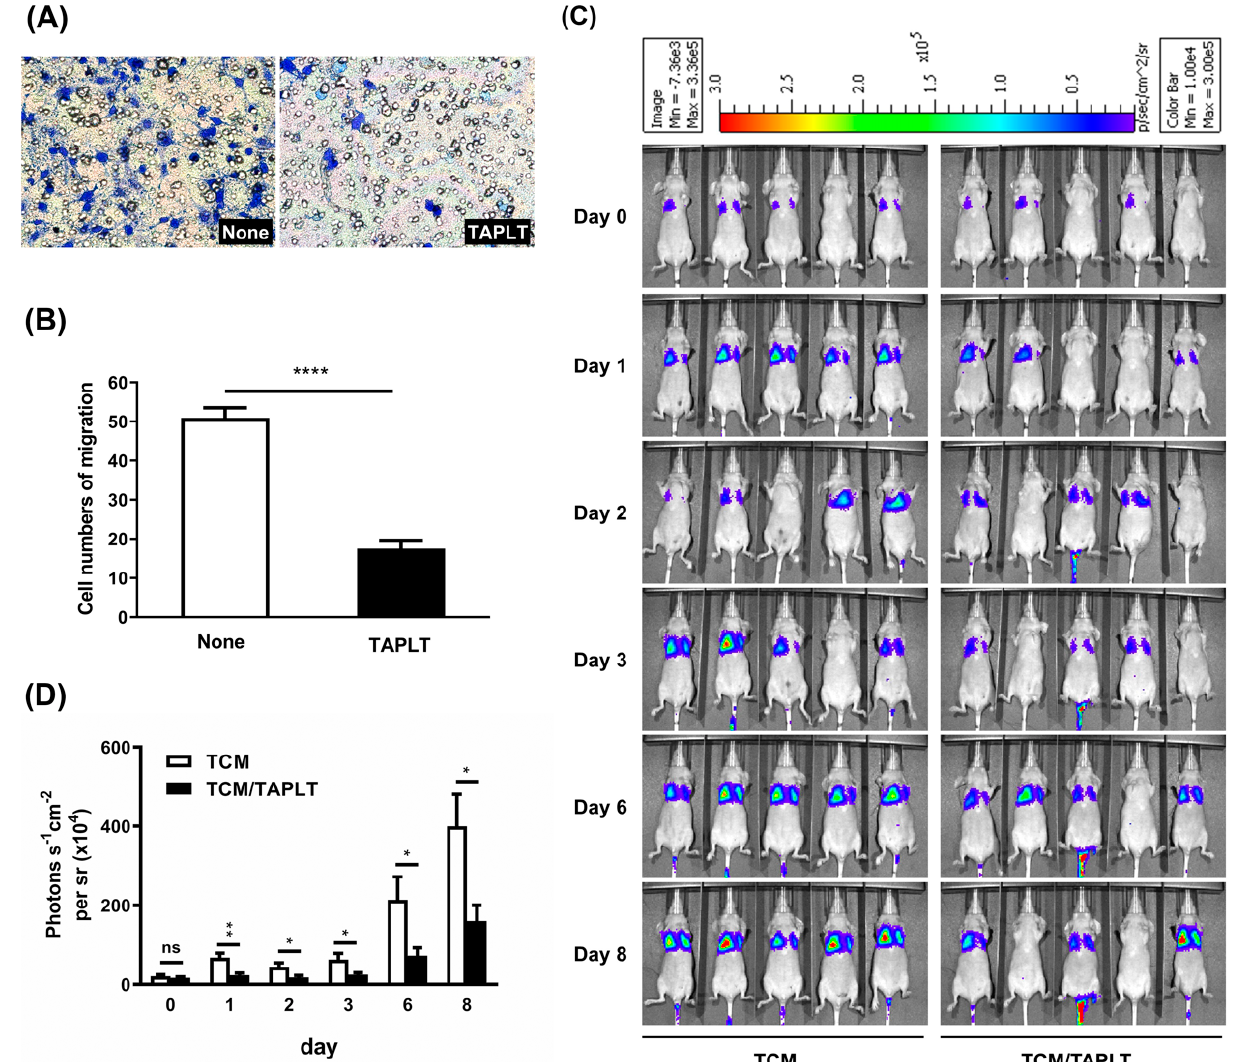
Figure 4. TAPLT inhibit tumor cell migration and metastasis. ( A ) MOSEC were co-cultured with TAPLT in a transendothelial migration assay through a 2H11 EC monolayer. Migrated cells were stained blue with DAPI. Representative images at 200 × magnification were shown. ( B ) Number of migrated MOSEC was counted. Mean ± SEM; ****: p < 0.0001. ( C ) Representative images of in vivo pulmonary colonization assay of MOSEC in BALB/c nude mice without TAPLT co-administration (“TCM”) or with TAPLT co-administration (TCM plus TAPLT or “TCM/TAPLT” in figure). Lung metastatic foci were detected by IVIS (In Vivo Imaging System). Each animal was imaged on Day 0, Day 1, Day 2, Day 3, Day 6, and Day 8 for photon fluxes produced by Luciferase-tagged MOSEC (MOSEC/Luc). ( D ) Bioluminescent signals of the pulmonary colonization assay seen in ( C ) were quantitated (n = 18 for Day 0 to Day 6; n = 10 for Day 8). Mean ± SEM; *: p < 0.05, and **: p < 0.001; ns: not significant. All comparisons were two-group comparisons ( t -test) as indicated.